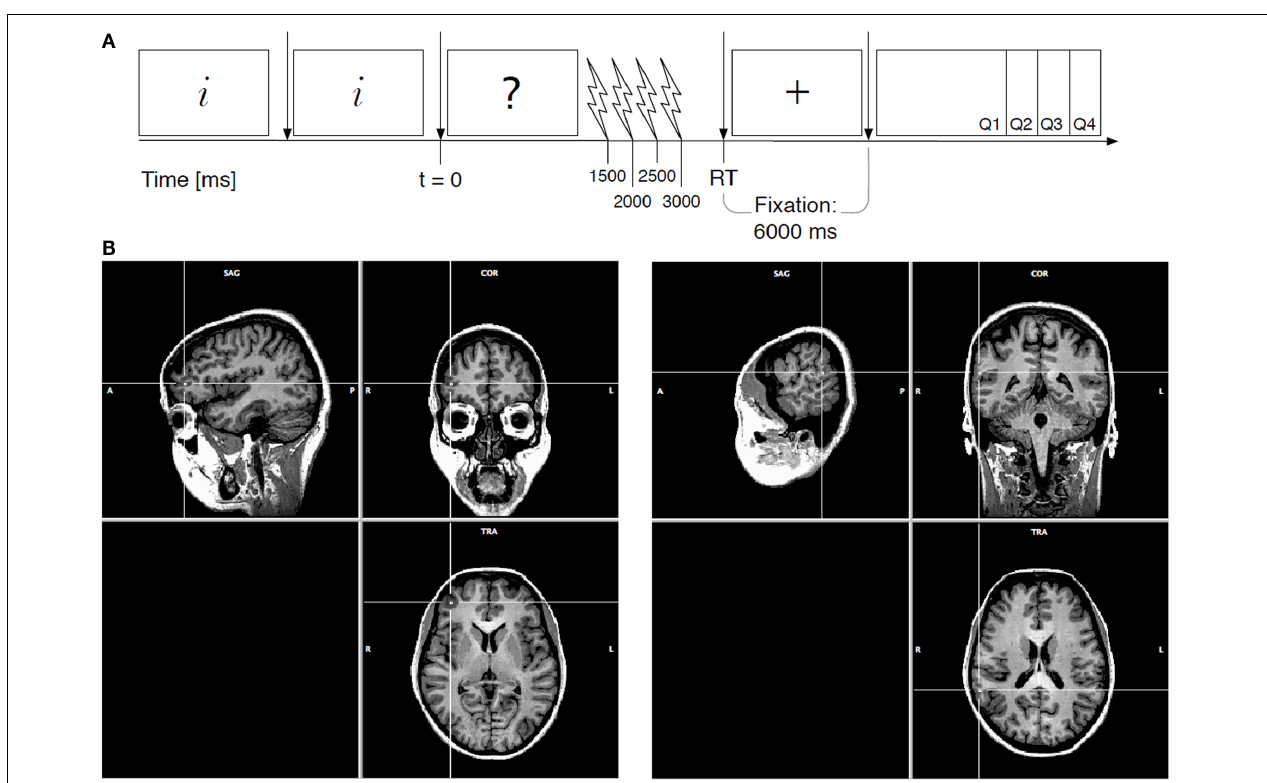
FIGURE 1 | Schematic overview of a single trial and stimulation areas. (A) The first two screens provide the participant with information about the dilemma, the third screen asks the question to which the participant responds “appropriate” or “inappropriate.” Reaction time is measured from the onset of